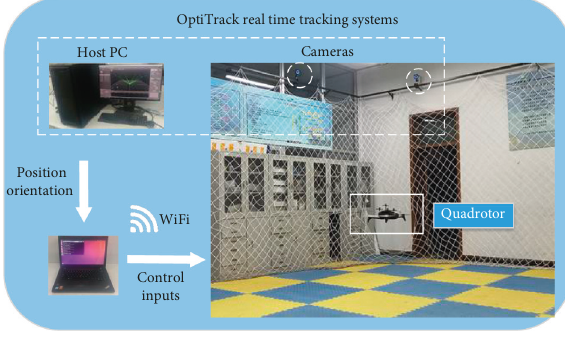
Figure 12: The quadrotor platform.